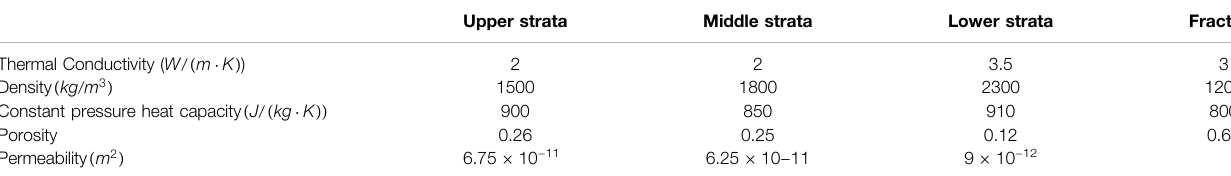
Upper strata Middle strata Lower strata Fracture